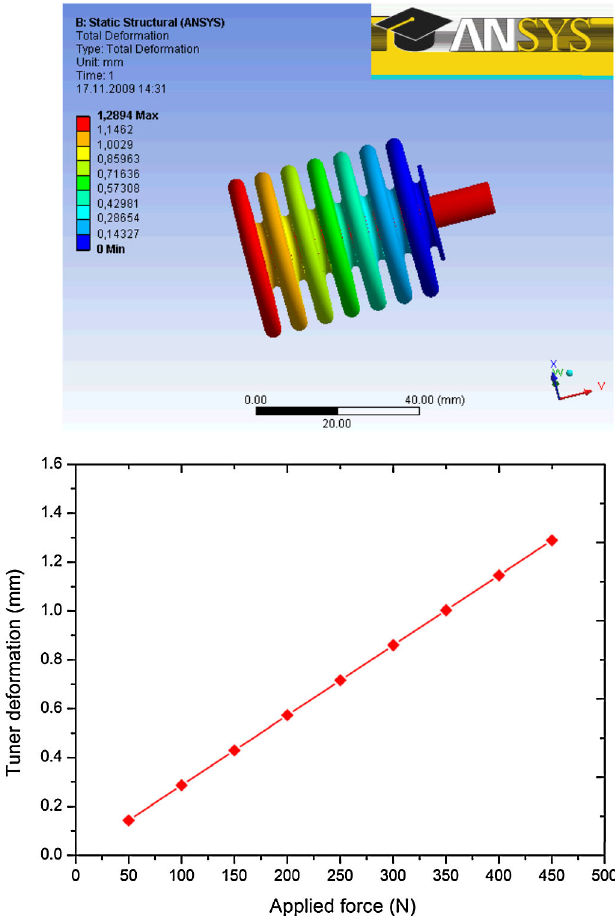
FIG. 6. (Color) Structural ANSYS simulation of a bellow tuner model (top) and deformation of the bellow tuner depending on several forces (bottom) [17].